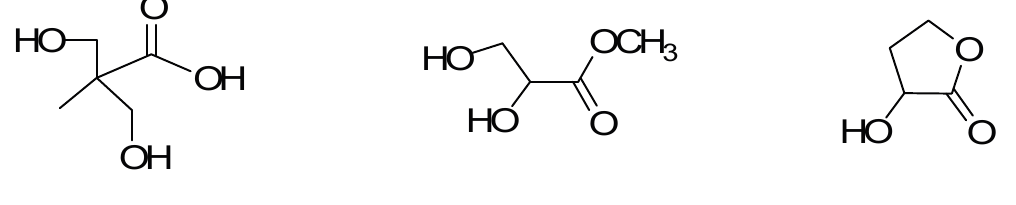
Figure 1. Substrates for the non-nucleosidic polyaminonucleoside